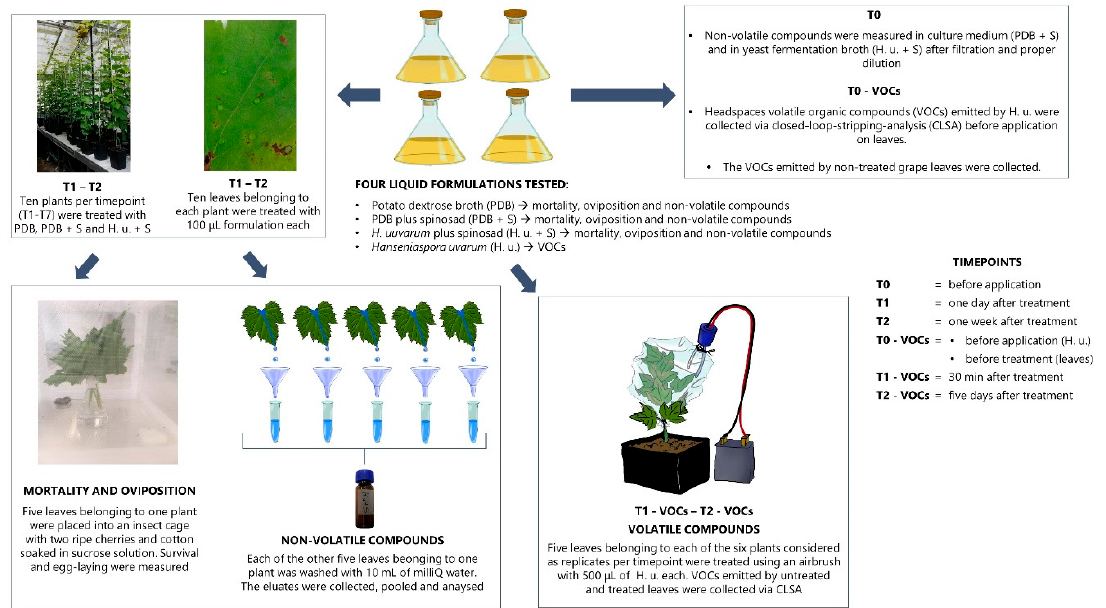
Figure 1. Experimental design of the treatments on potted grape plants in the greenhouse. A scheme of the assays and analyses performed is reported.